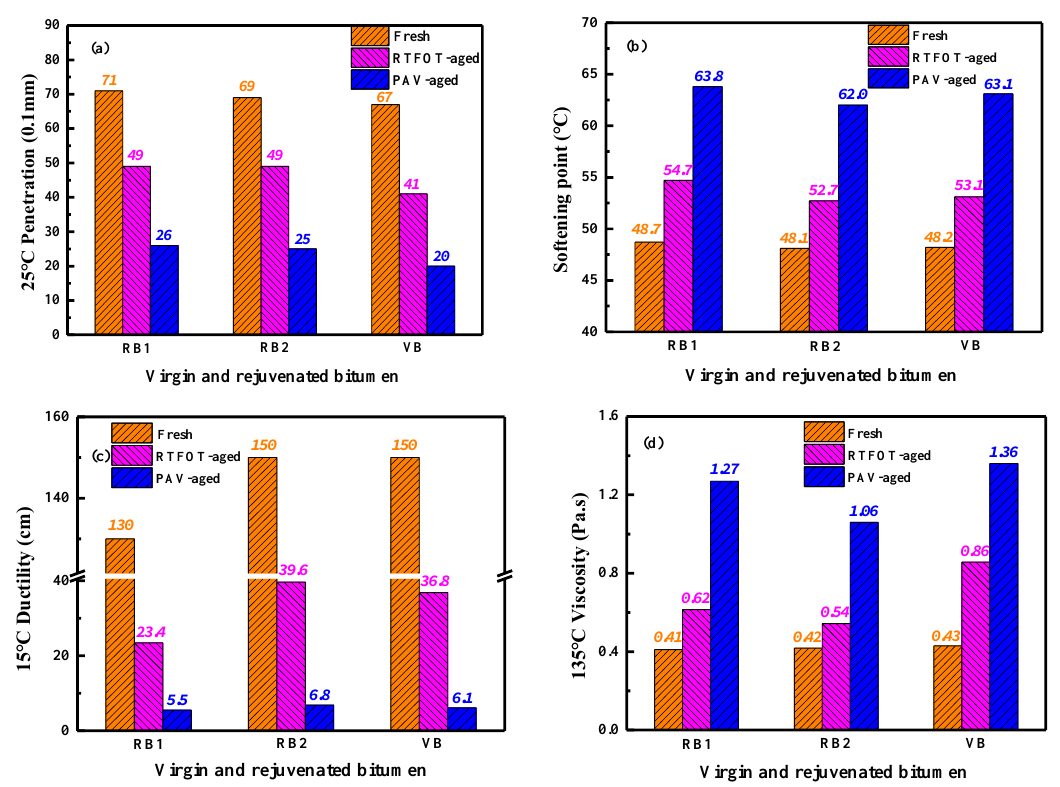
Figure 12. The physical properties of virgin and rejuvenated bitumen.